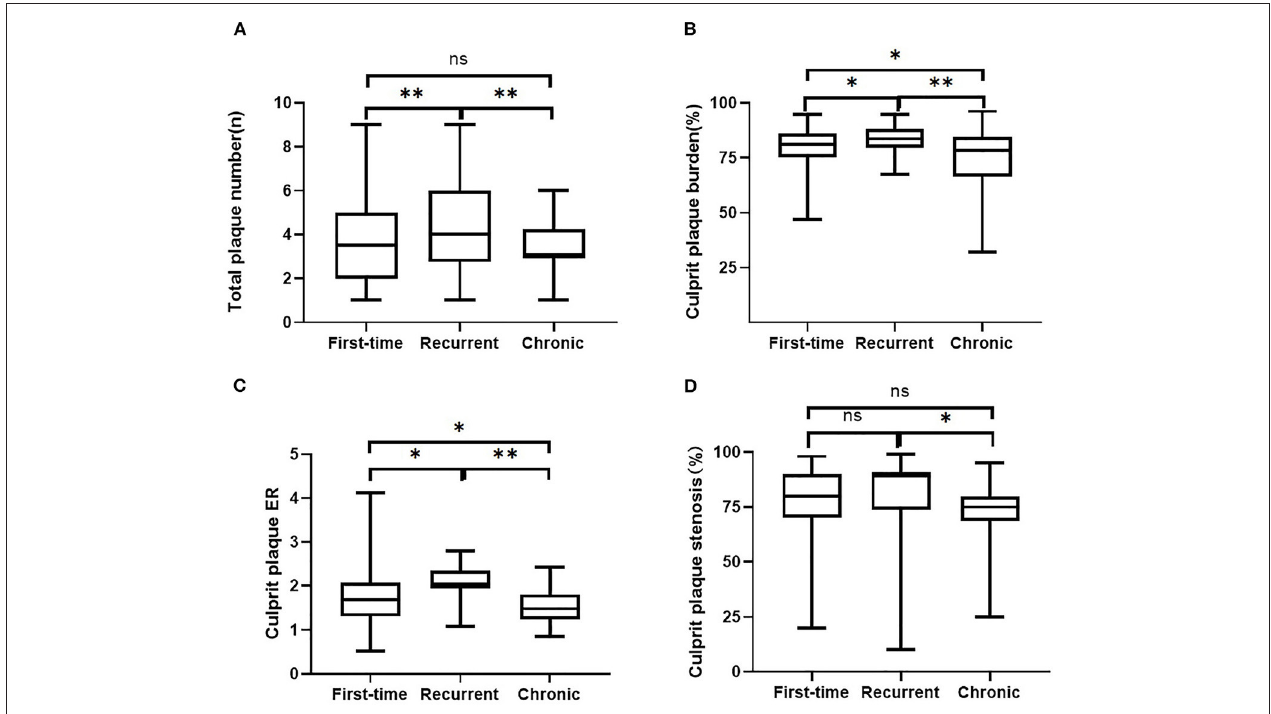
FIGURE 2 | Comparisons of intracranial plaque features among the three groups. Intracranial plaque numbers (A) and culprit plaque features ( B , plaque burden, C , enhancement ratio, D , degree of stenosis) on 3D MR-VWI in patient groups with the first-time acute stroke, recurrent acute stroke, and in patients with chronic stroke. ER, enhancement ratio. ** p < 0.001, * p < 0.05, ns, no significant.